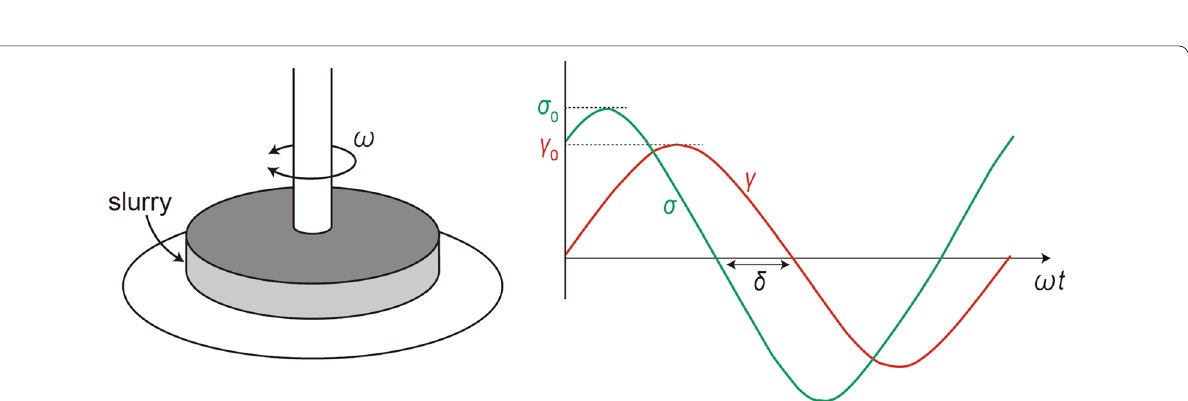
Fig. 3 Schematic image of dynamic viscoelasticity measurement (left) and strain/stress relationship